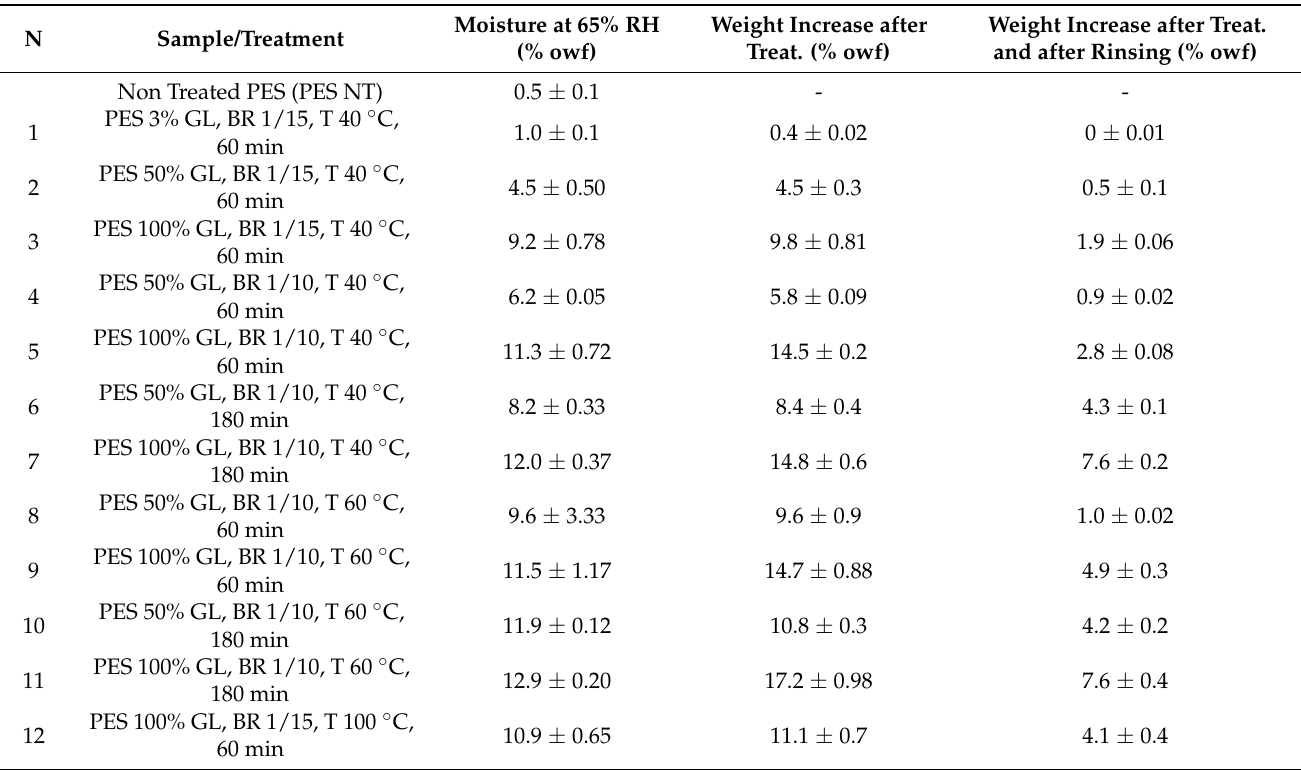
Table 2. Moisture at 65% RH and increase in weight of PES/GL treatments before and after rinsing. Bath exhaustion of GL solution at different concentrations (3%, 50% and 100% owf), different bath ratio BR 1/15, 1/10, different temperatures T, 40 ◦ C, 60 ◦ C at 60 and 180 min.